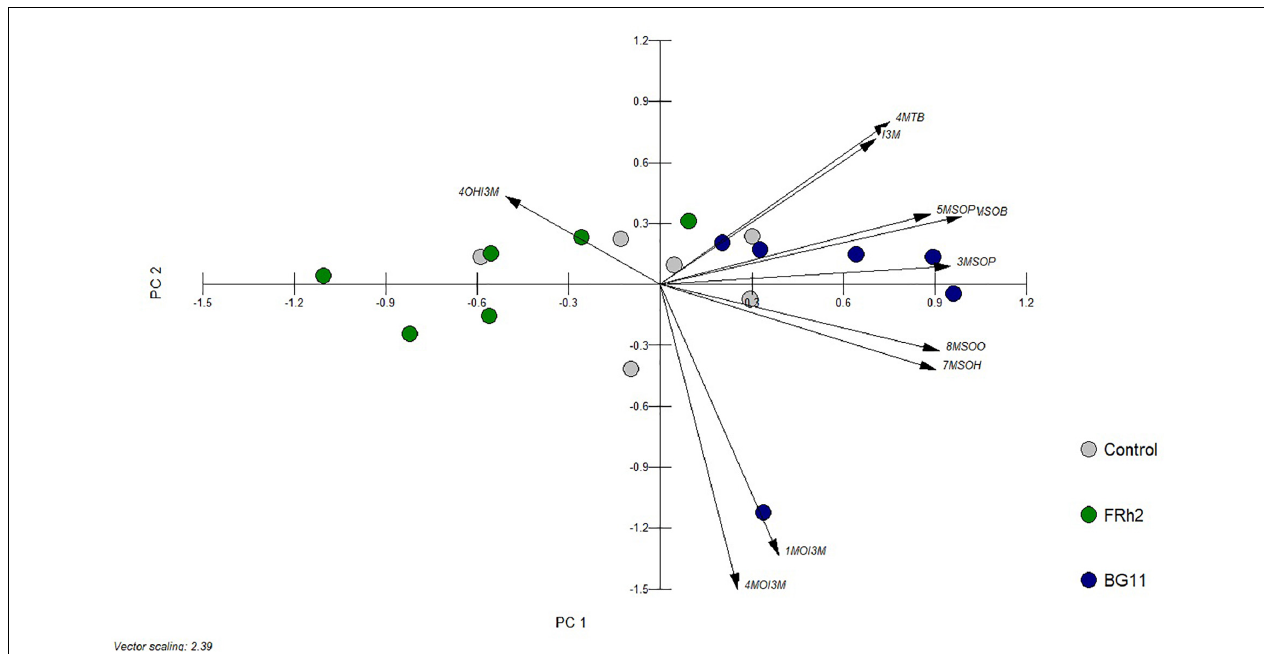
FIGURE 9 | Bi-plot of principal component analysis (PCA) of glucosinolates in A. thaliana leaves. Plants were mock-inoculated (control) or colonised by B. bassiana strains FRh2 and BG11, respectively. Glucosinolates (GLS): 3MSOP, 3-methylsulfinylpropyl GLS; 4MSOB, 4-methylsulfinylbutyl GLS; 5MSOP, 5-methylsulfinylpentyl GLS; 6MSOH, 6-methylsulfinyl-heptyl GLS; 7MSOH, 7-methylsulfinylheptyl GLS; 4MTB, 4-methylthiobutyl GLS; 8MSOO, 8-methylsulfinyl-octyl GLS; 4MOI3M, 4-methoxyindol-3-ylmethyl GLS; 1MOI3M, 1-methoxyindol-3-ylmethyl GLS; 4OHI3M, 4-hydroxyindol-3-ylmethyl GLS; I3M, indol-3-ylmethyl GLS. PC1 = 49%, PC2 =